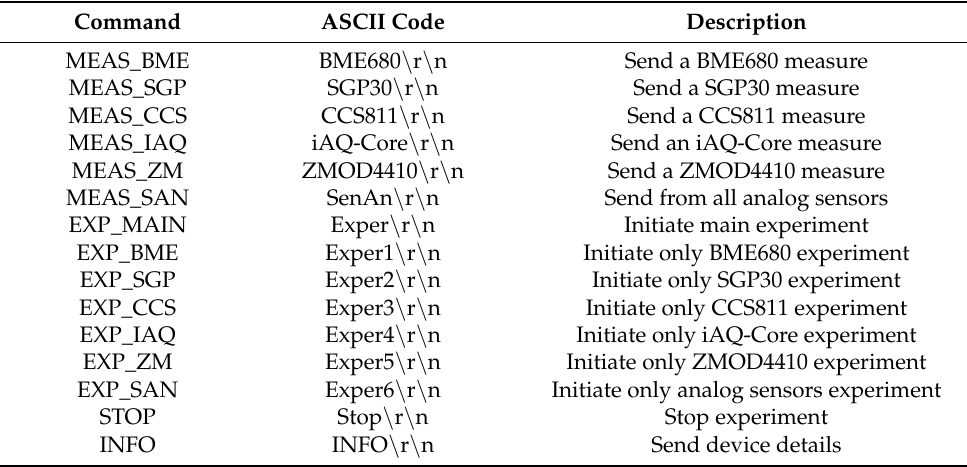
Table 2. ASCII codes for multisensorNOSE experiments